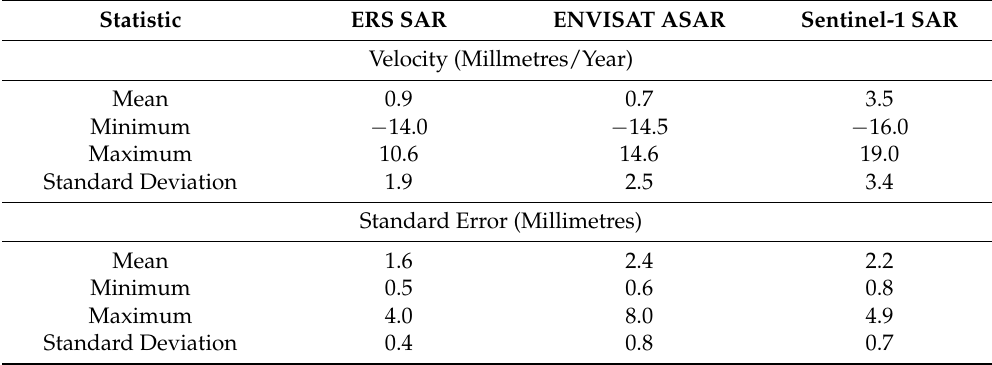
Table 1. A comparison of the statistics of ERS, ENVISAT and Sentinel-1 ISBAS analyses over the Northumberland